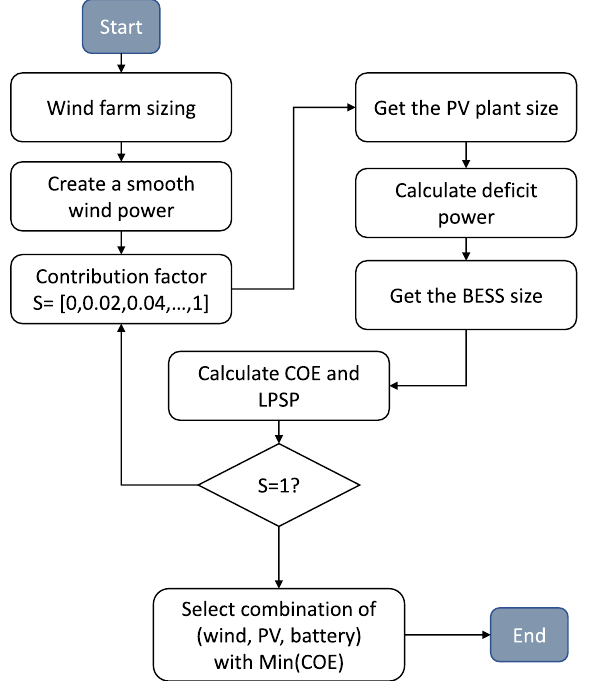
Figure 1. Process flow for sizing the